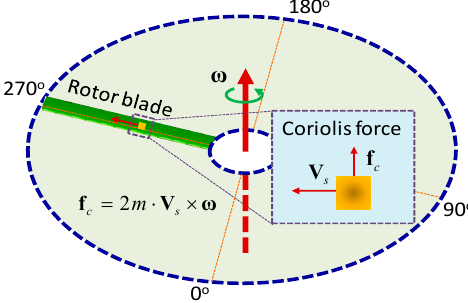
Figure 17. Schematic of Coriolis force on airflow near blade surface.